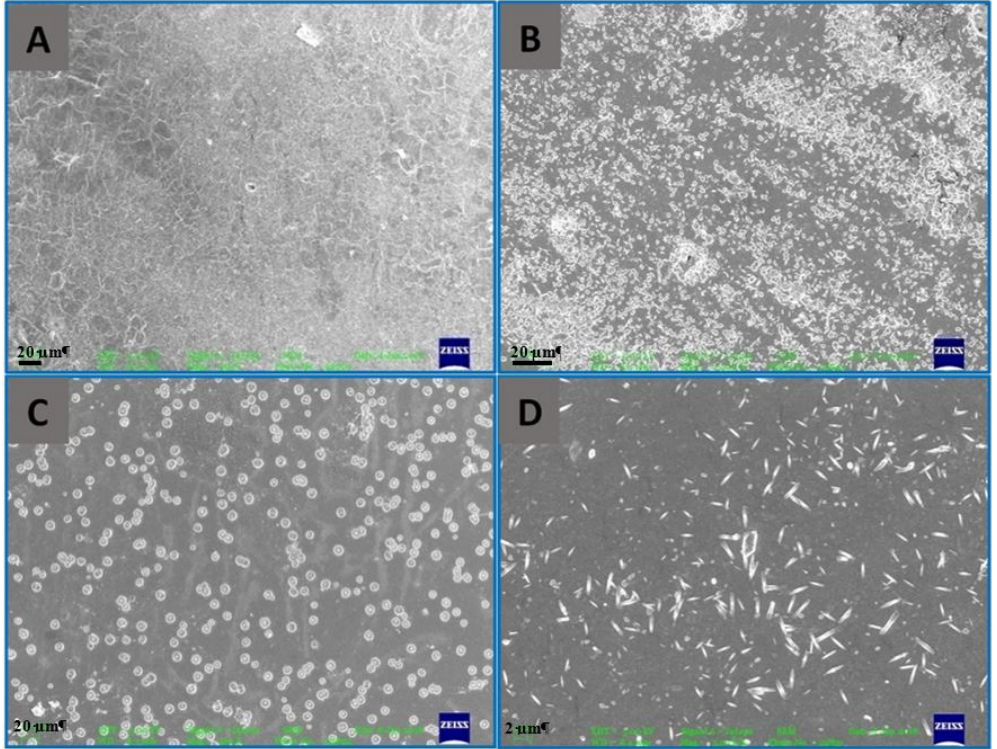
Figure 4. Scanning electron microscopy (SEM) micrographs of the developed hybrid films; ( A ) chitosan and gelatin film (CH / GL), ( B ) chitosan and gelatin with 1% ZnO NPs film (CH / GL / ZnO (1%)), ( C ) chitosan and gelatin with 2% ZnO NPs film (CH / GL / ZnO (2%)), and ( D ) chitosan and gelatin with 4% ZnO NPs film (CH / GL / ZnO